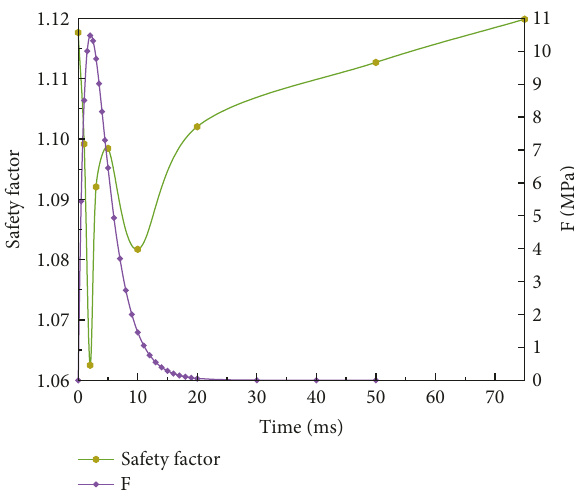
Figure 16: Change of the safety factor during a single equivalent dynamic blast load